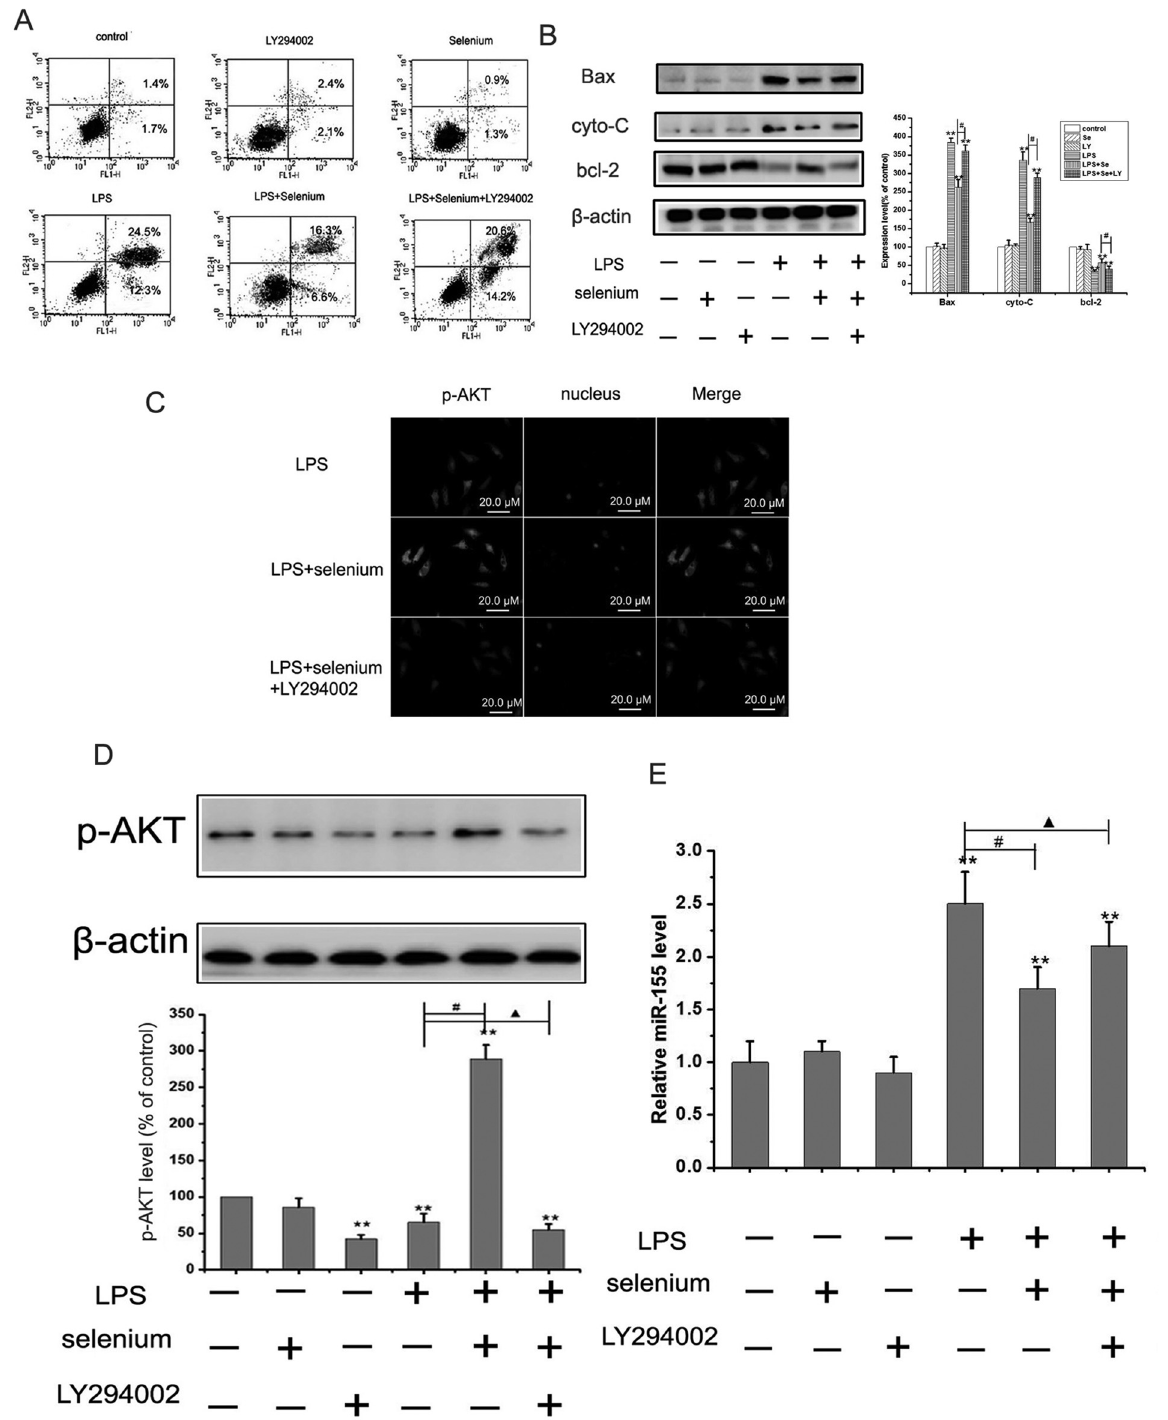
Figure 5 - Selenium inhibited cells apoptosis and regulated miR-155 level through PI3K/Akt signaling pathway. (A) MC3T3-E1 cells were incubated in 100 ng/ml LPS in the presence or absence of 4 ng/ml sodium selenite with or without 10 (cid:3) M LY294002 for 24 h, and the apoptosis was detected with annexin V-FITC/PI double staining. Results are representative of three experiments. (B) Cells were treated as aboved, western blots were performed with theantibodiesindicated.RelativeexpressionofBax,cytochromecandbcl-2werecalculatedandnormalizedtotheloadingcontrol (cid:2) -actin.Thedatawere mean (cid:6) SEM (n = 6). (** P < 0.01, vs. control, # P < 0.05, LPS +Se vs.LPS +Se+LY group) . (C): Cells were treated as above, and the p-AKT protein was stained and observed under a fluorescence microscope. (D): Cells were treated as above, and the p-AKT protein was detected by western blot. The data were mean (cid:6) SEM (n=6). (** P < 0.01, vs.control group;# P < 0.05, LPS vs. LPS+selenium group; (cid:2) P>0.05 LPS vs. LPS+selenium+LY294002 group) . (E) Cells were treated as aboved, and the miR-155 was detected by qRT-PCR. The data were mean (cid:6) SEM (n = 6). (** P < 0.01, vs.control group;# P < 0.05, LPS vs. LPS+selenium group; (cid:2) P>0.05 LPS vs. LPS+selenium+LY294002